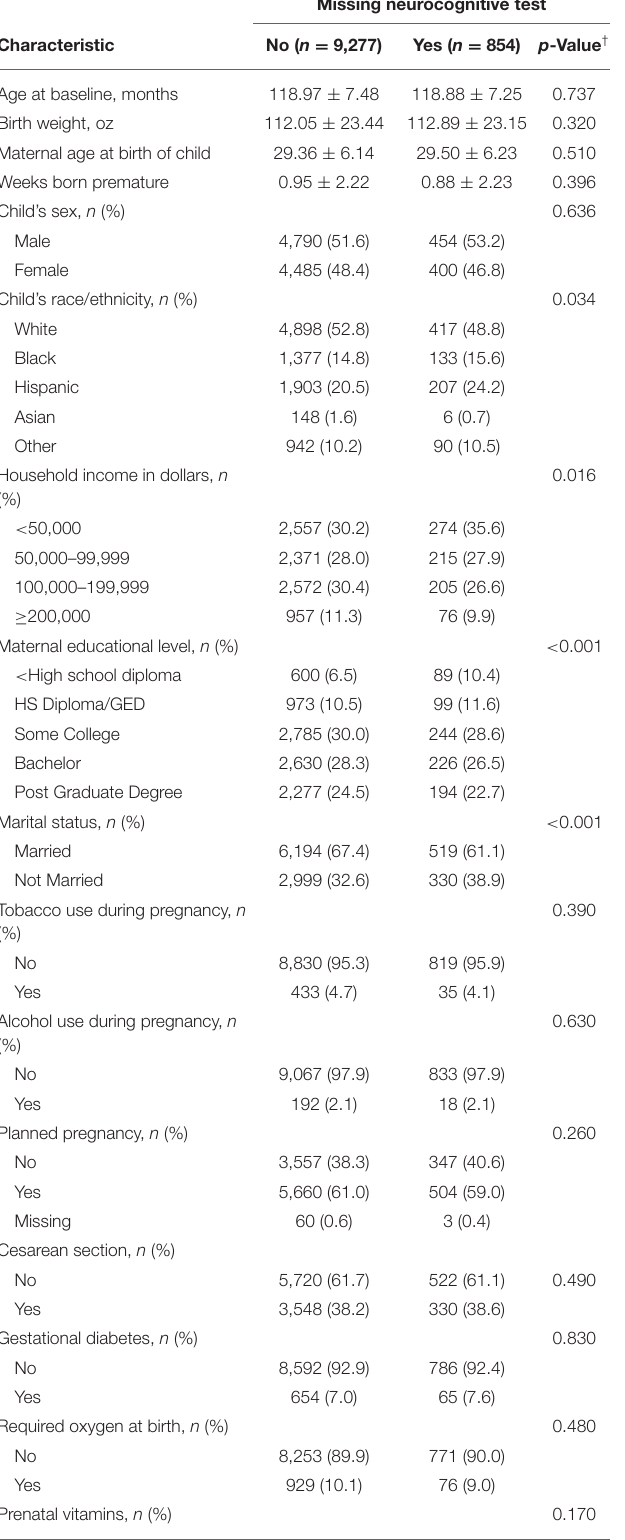
TABLE 2 | Characteristics of participants missing a neurocognitive test. Missing neurocognitive test